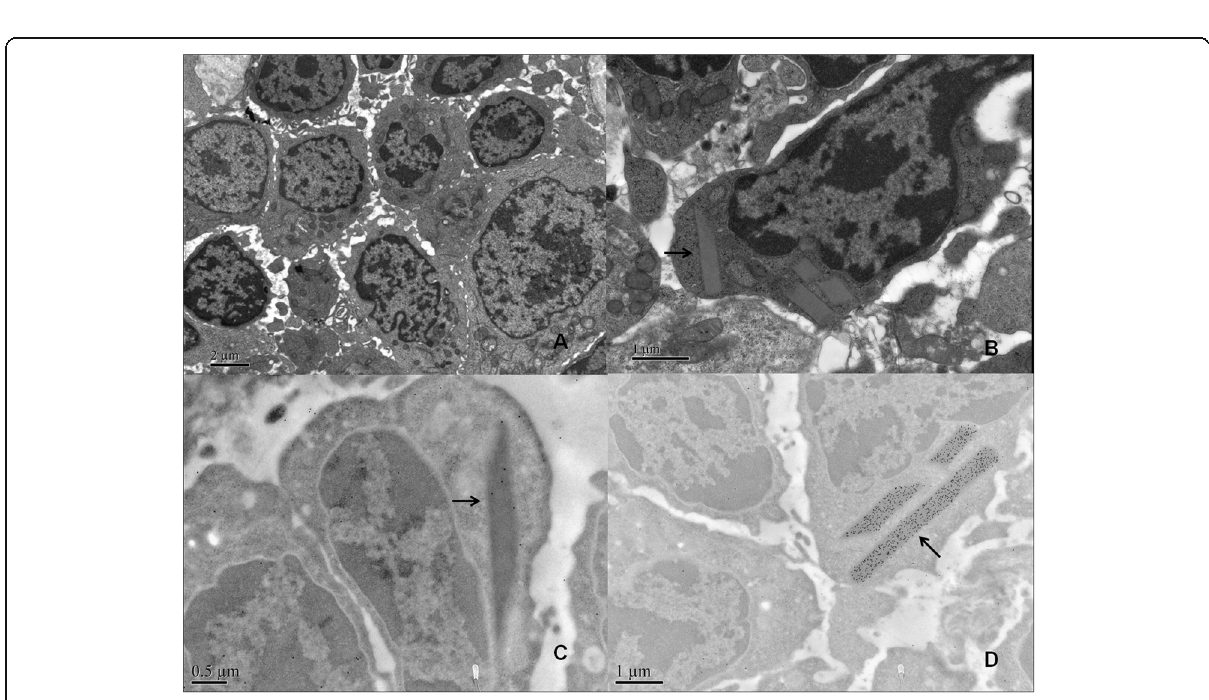
Fig. 3 Representative electron microscopy findings of renal biopsy in case 2. A . Neoplastic cells infiltration was seen in the renal interstitium (× 8000). B . Rhombic crystals were formed in infiltrating neoplastic cells as indicated the arrow (×25,000). C . Light kappa was not detected in neoplastic cells (Immunoelectron microscopy labelling, ×30,000). D . Intense light lamda was detected in the crystalline structures of neoplastic cells as indicated by the arrow (Immunoelectron microscopy labelling, ×